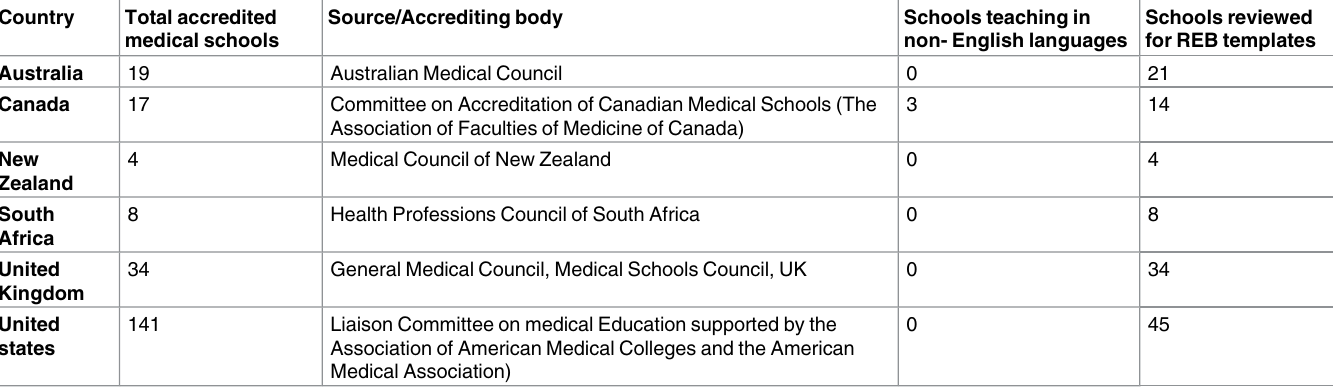
Table 1. Inclusion of medical